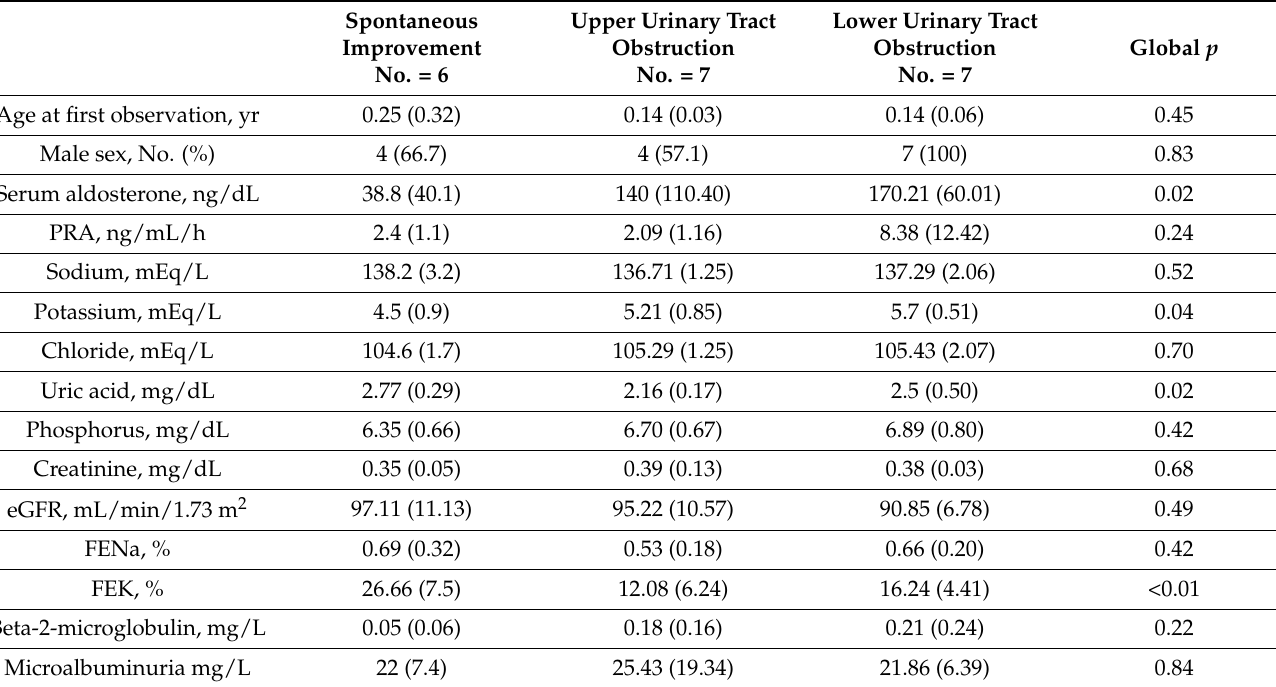
Table 2. Clinical and biochemical characteristics of patients classified on the basis of presence or no presence of spontaneous obstructive CAKUT improvement and on the basis of site of obstruction. For continuous variables, means ± SDS are shown. Abbreviations: FENa, fractional excretion of Na; FEK, fractional excretion of K; PRA, plasma renin